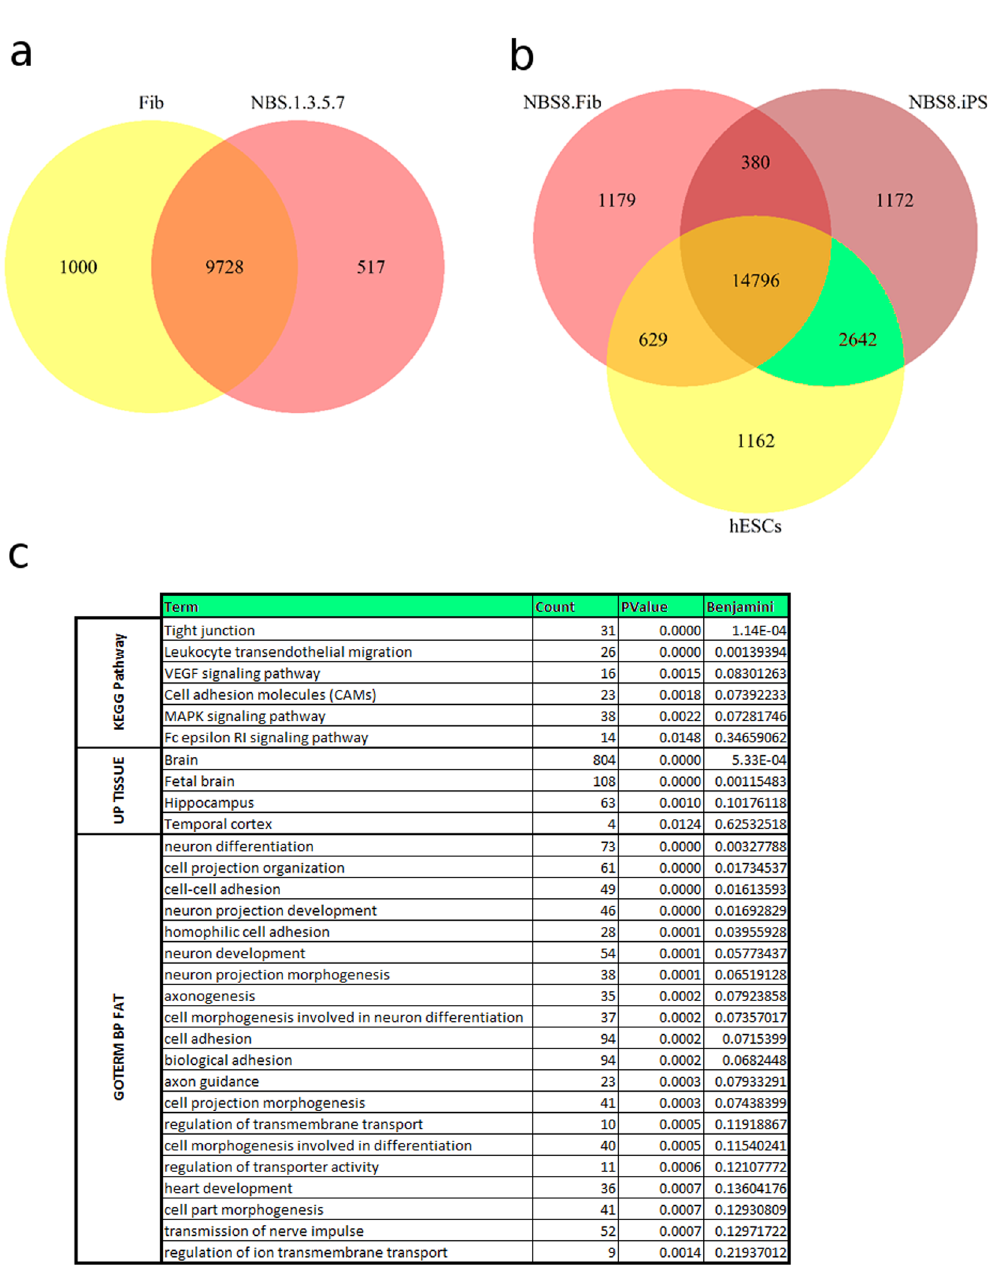
Figure 1. Statistics of Venn diagram analysis among NBS fibroblasts, NBS iPSCs and hESCs. The overlap of significantly expressed genes (detection p value < 0.01) in ( a ) Fibroblasts comparing the averaged group of NBS with unaffected cell lines and in ( b ) NBS fibroblasts versus NBS-iPSCs and unaffected hESCs. ( c ) Annotations for genes commonly expressed in NBS-iPSCs and hESCs but not NBS fibroblasts resulting from functional annotation analysis via the DAVID web tool. The output of the DAVID analysis was condensed to the count of genes annotated with the indicated category, p-value and Benjamini-Hochberg -correction for multiple-testing as calculated based on the Fisher-exact